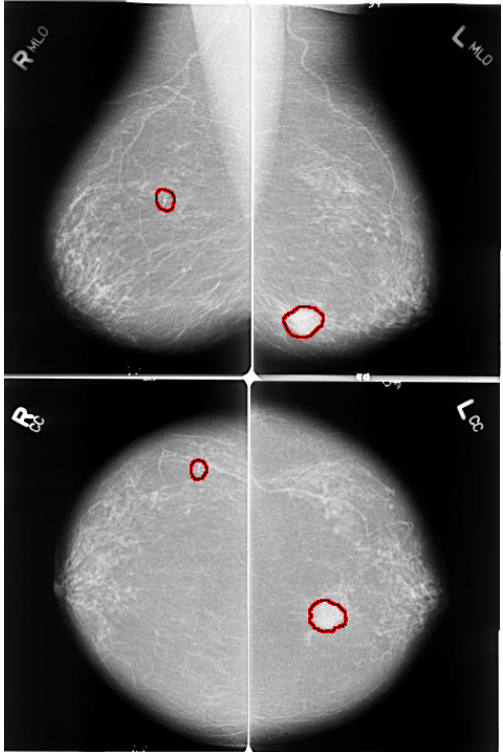
Figure 2. MLO and CC views of mammogram. Red highlighted sections in the images present abnormalities. Left images shows right MLO and CC views of benign calcification in upper outer quadrant of right breast. Right images shows MLO and CC views of spiculated mass lesion in lower inner quadrant of left breast